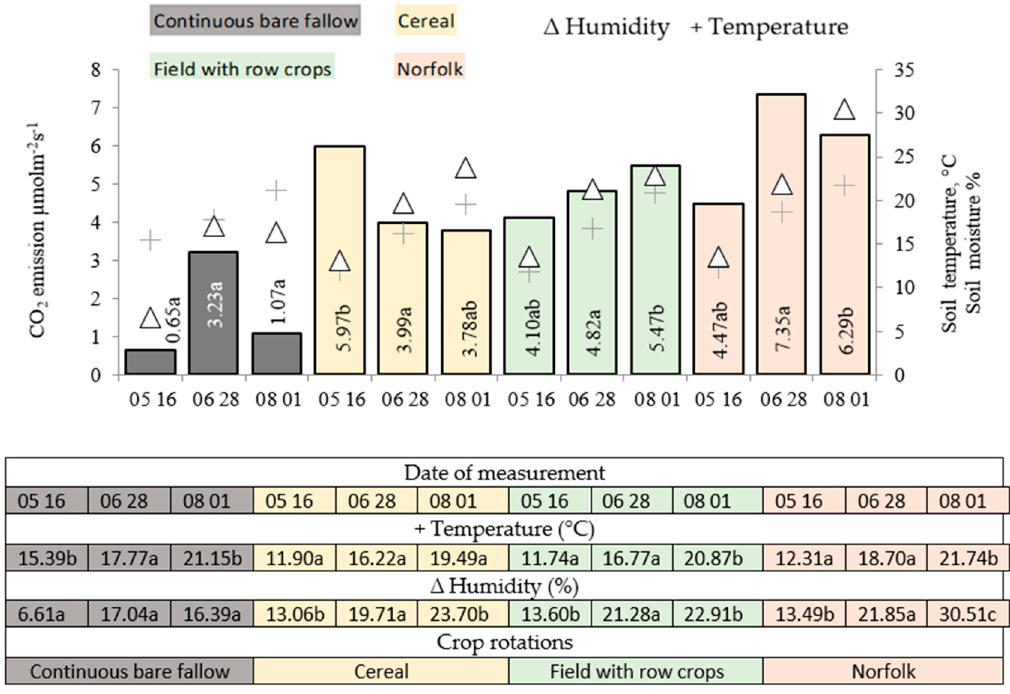
Figure 2. Soil moisture, temperature, and CO 2 emissions in the 2017 winter wheat crop. Note: a–c indicate significant differences between the treatments ( p ≤ 0.05). FAL-CONTROL, continuous bare fallow; LEG-CER (CE), winter wheat pre-crop was a vetch and oat mixture for green forage while the crop rotation was cereal; FAL-CER (FWR), winter wheat pre-crop was black fallow while the crop rotation was field with row crops; GRS-CER (NOR), winter wheat pre-crop was a clover–timothy mixture while the crop rotation was Norfolk.